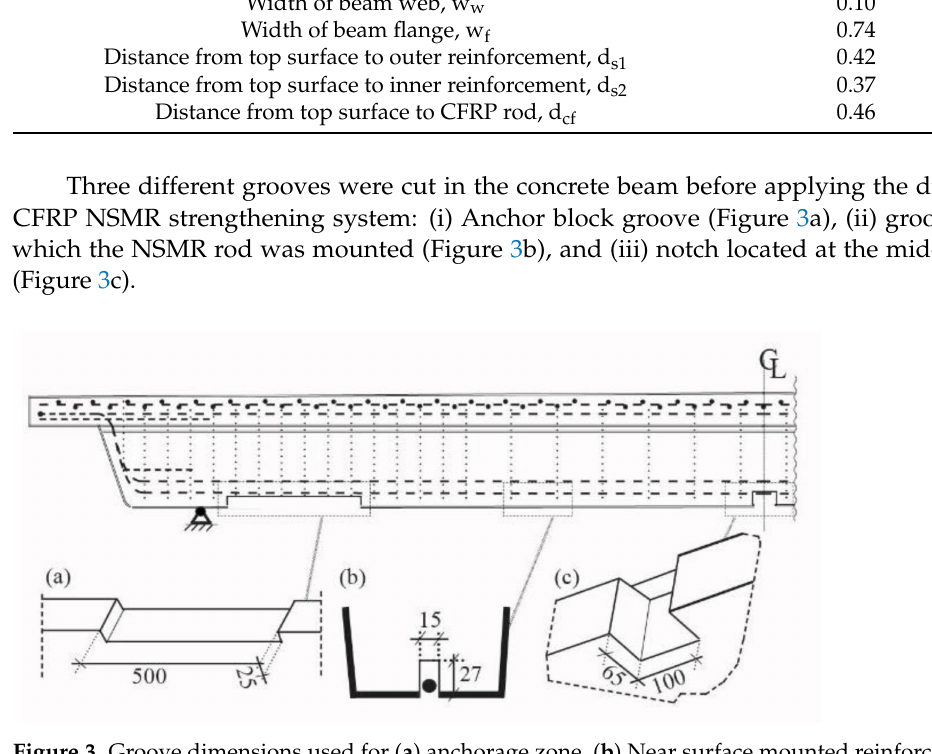
Free length of the carbon fiber reinforced polymer (CFRP) rod, L f.cf